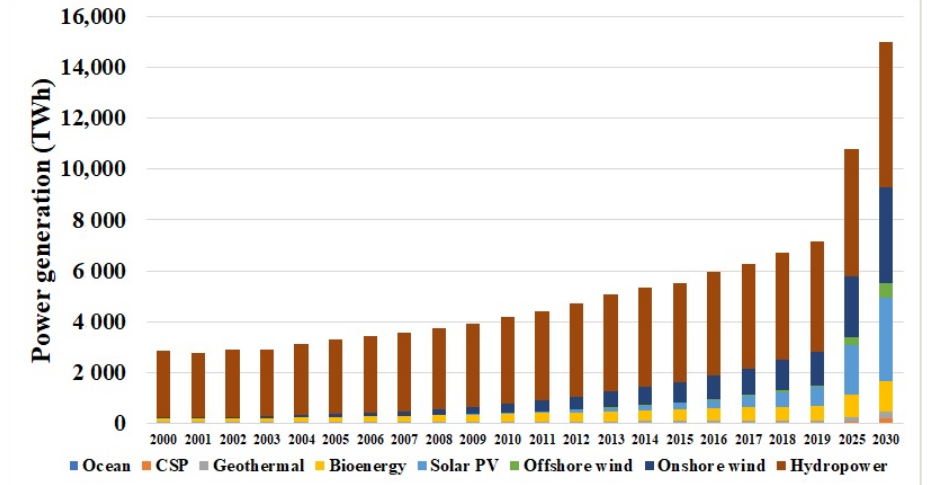
Figure 1. Power generation from renewable energy sources globally